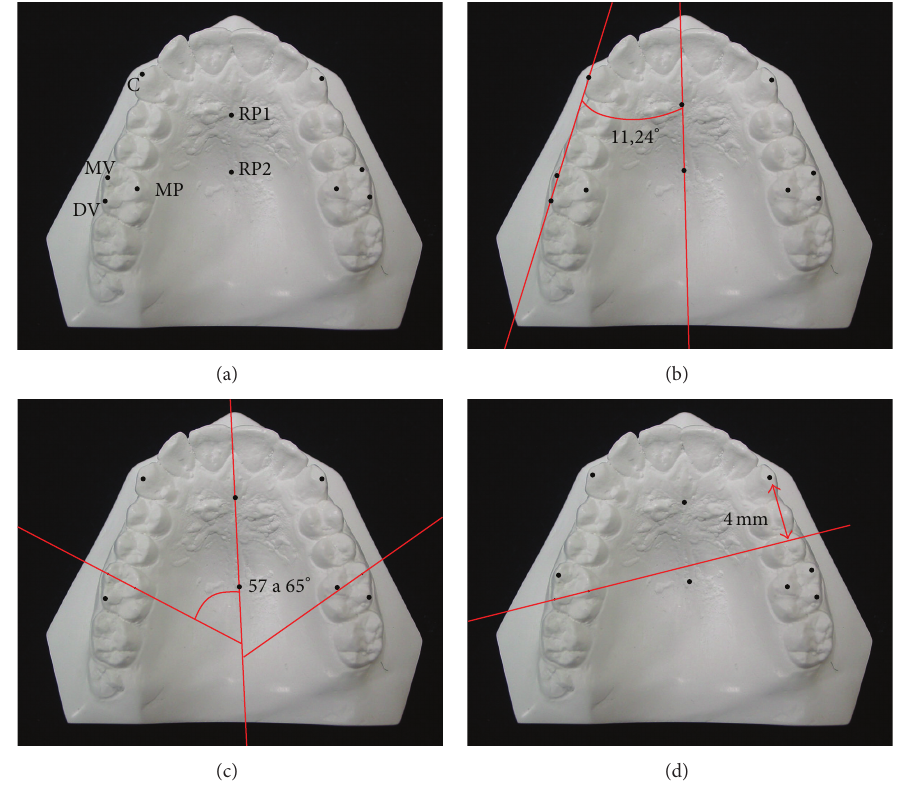
Figure 1: Determination of rotation of the first maxillary molar. (a) The defined points were initially marked on the scanned model. The three indicators were then calculated as follows: (b) indicator 1 (angle of Henry); (c) indicator 2 (angle of Friel); and (d) indicator 3 (line of